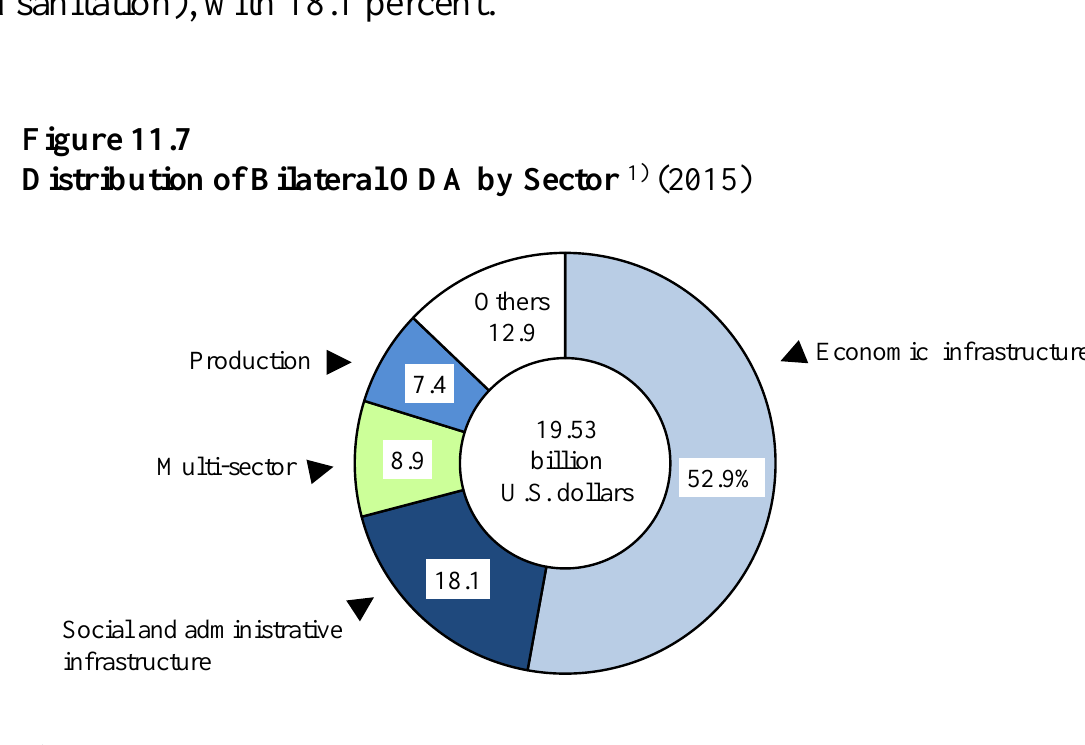
19.53 billion U.S.